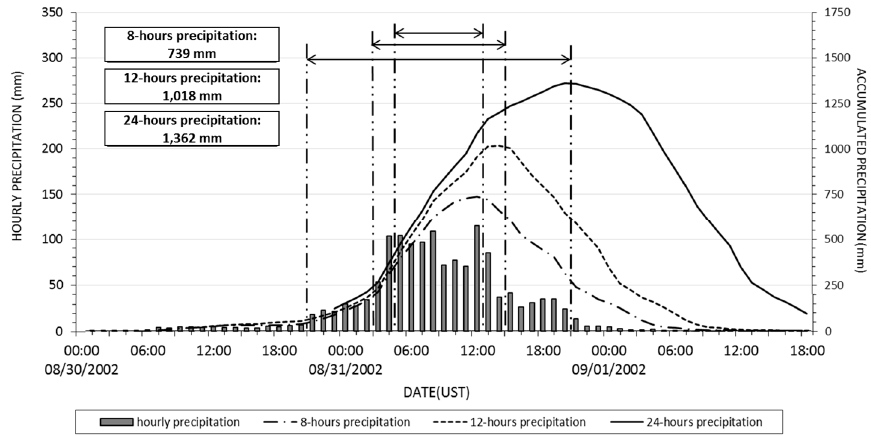
Figure 7. Estimation of RCM__PMP at the Gangneung.